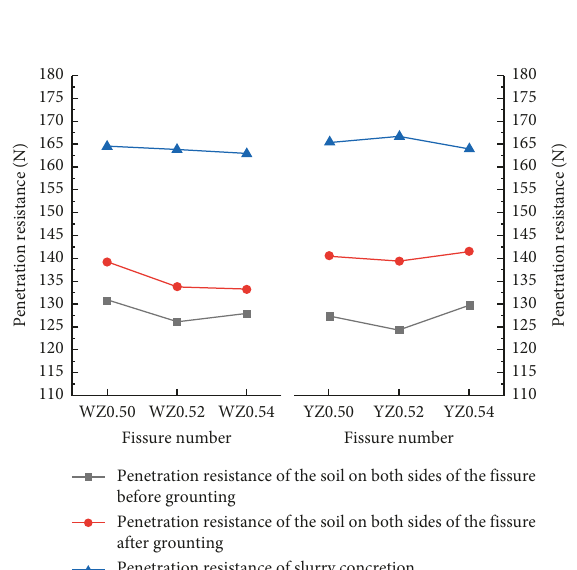
Figure 6: Wave velocity test results.